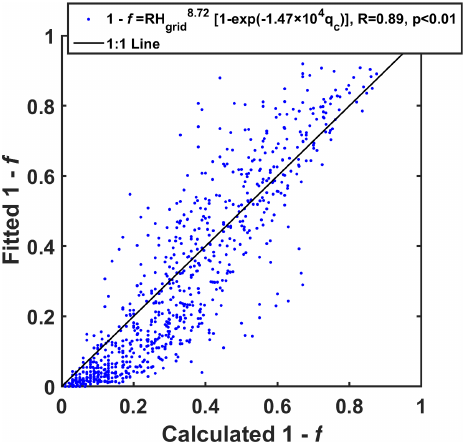
Figure 8. The fitted 1 − f as a function of the calculated 1 − f . The fitted 1 − f is obtained by the fitting functions with grid mean relative humidity (RH grid ) and cloud water mixing ratio ( q c ). The black line denotes the 1:1